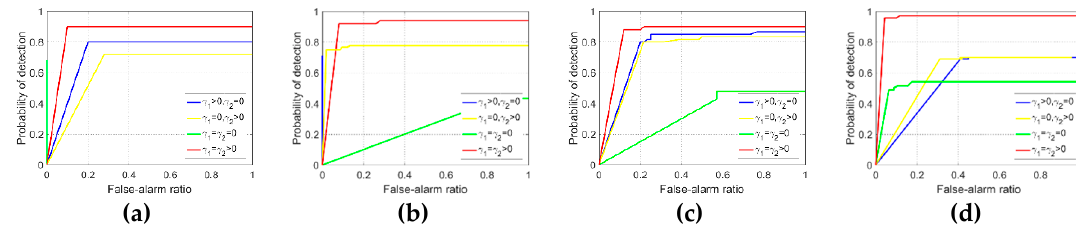
Figure 5. Performance of the proposed patch and feature sparse graph regularizations on different scenes, such as ( a ) deep-space, ( b ) sky-cloudy, ( c ) sea-sky, ( d ) terrain.